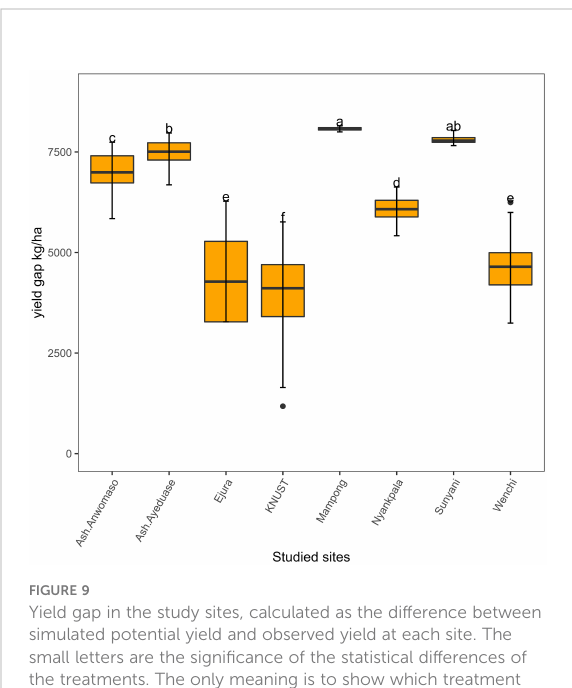
FIGURE 9 Yield gap in the study sites, calculated as the difference between simulated potential yield and observed yield at each site. The small letters are the signi fi cance of the statistical differences of the treatments. The only meaning is to show which treatment are signi fi cantly different and the ones that are not signi fi cantly different. The letters were automatically generated by the statistical test.